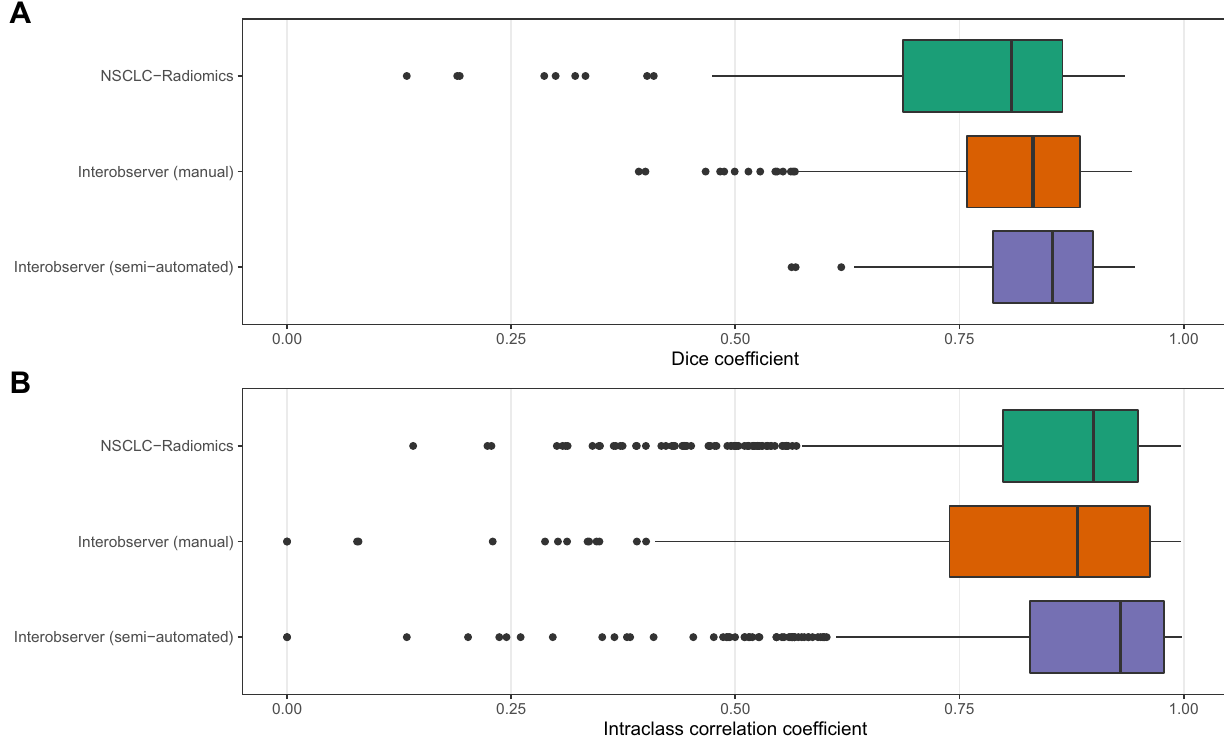
Figure 2. Boxplots of Dice coefficients (DC) and intraclass correlation coefficients (ICC). This figure summarises the ( A ) DC and ( B ) ICC values for the ‘NSCLC-Radiomics’, ‘Interobserver (manual)’ and ‘Interobserver (semi-automated)’ sets of